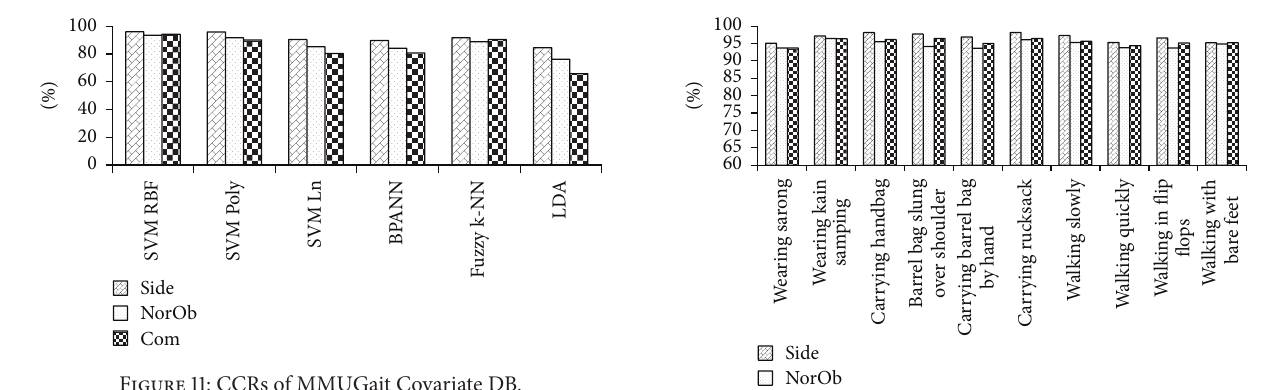
Figure 11: CCRs of MMUGait Covariate DB.